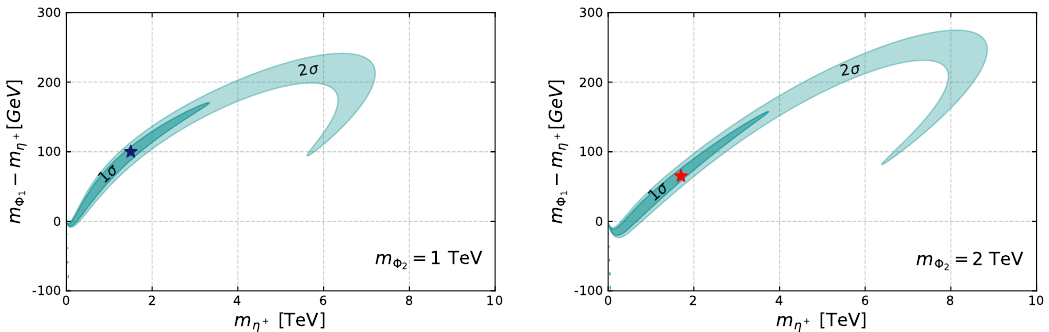
− m versus m plane allowed by the fit of the η + η + 1 = 1 TeV ( m Φ = 2 TeV). In both cases, the mixing 2 2